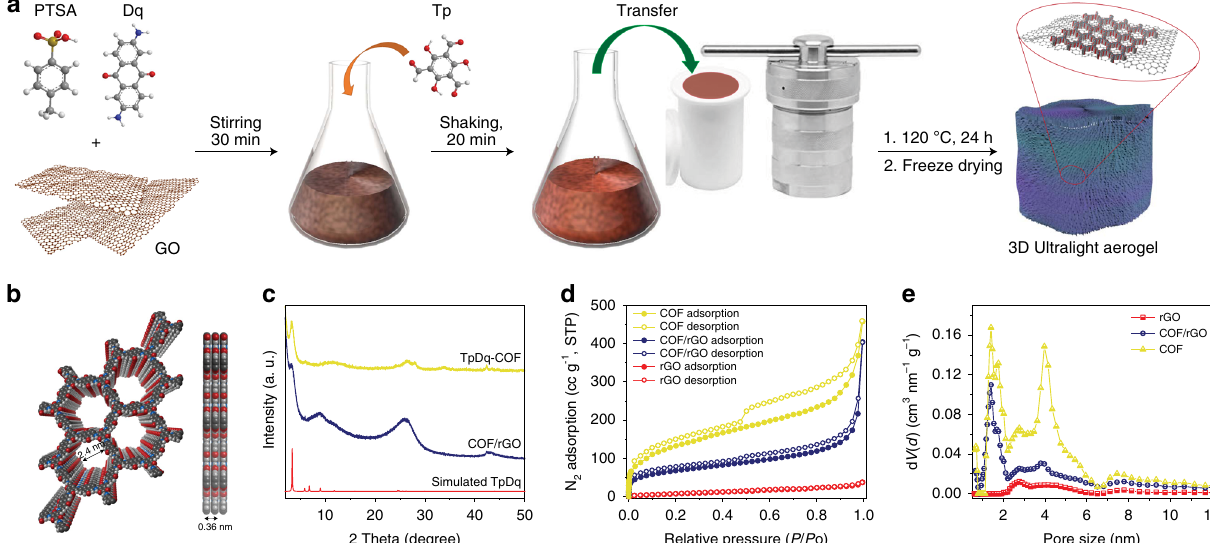
Fig. 1 Schematic representation of COF/rGO aerogel synthesis. a Scheme of the synthetic procedure for the preparation the COF/rGO aerogel. b Space- fi lled model of TpDq-COF from top and side views. c PXRD patterns of the pure COF and COF/rGO compared with a simulated XRD pattern from the modelled structure with eclipsed stacking. d N 2 adsorption-desorption isotherms of rGO, COF/rGO and COF. e , Pore size distribution for rGO, COF/rGO and COF obtained using the NLDFT